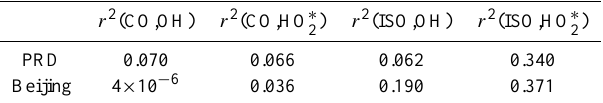
Table 2. Correlation coefficients ( r 2 ) between observed OH and HO ∗ radicals with the CO and isoprene concentrations in both PRD 2 and